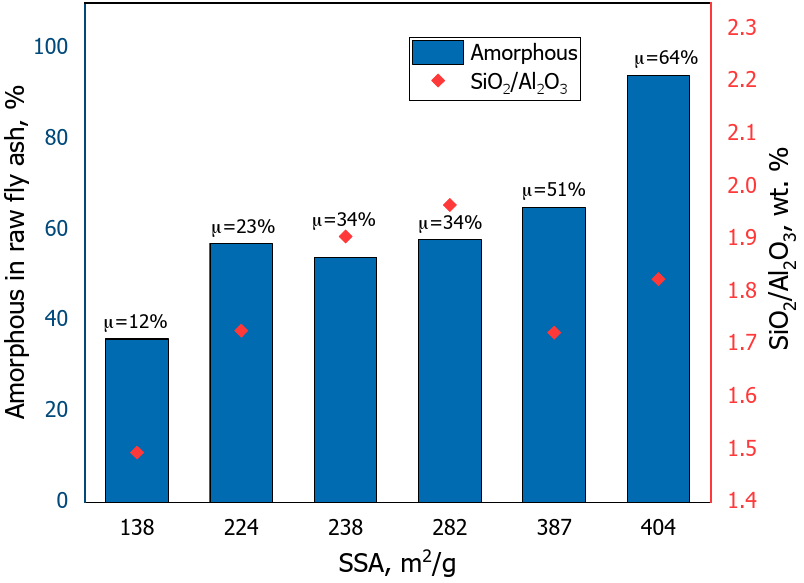
Figure 5. Dependences between surface properties of investigated samples and raw fly ash properties.